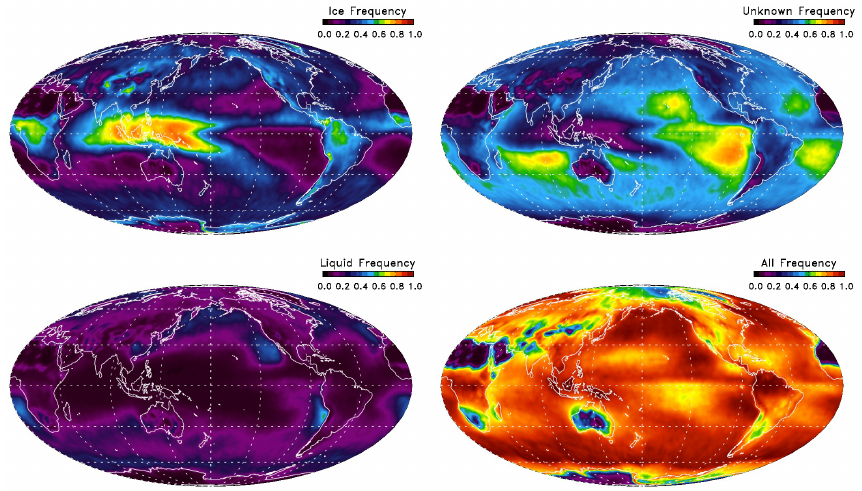
Fig. 5. Cloud thermodynamic phase for ice (upper left), liquid (lower left), unknown phase (upper right), and the sum of the three phases (lower right) for 2007. The relative global frequencies of occurrence (% of total AIRS FOVs) are 26.5% for ice, 16.2% for liquid, and 34.2% for